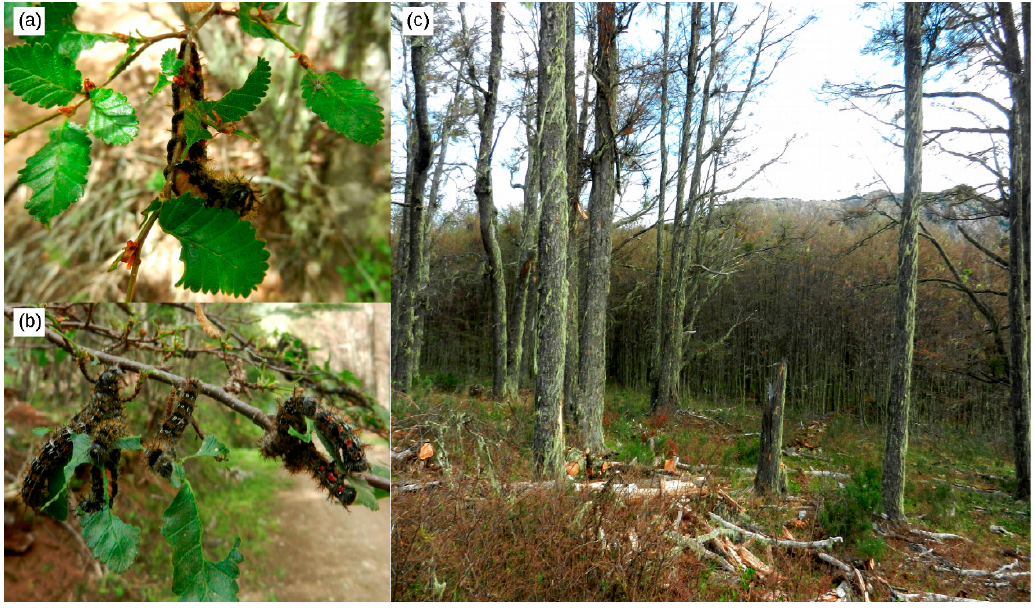
Figure 1. Ormiscodes amphimone outbreak affecting deciduous broad-leaf Nothofagus pumilio forests in the Trapananda National Reserve, southern Chile: ( a ) An individual of O. amphimone caterpillar feeding on N. pumilio leaves; ( b ) Group of caterpillars defoliating a N. pumilio tree; ( c ) A totally defoliated N. pumilio forest (grey forest) after the outbreak event of 2015–2016. All pictures were taken by the authors during a field campaign in the Trapananda National Reserve in February 2016. Location of the Reserve is given in Figure 2.